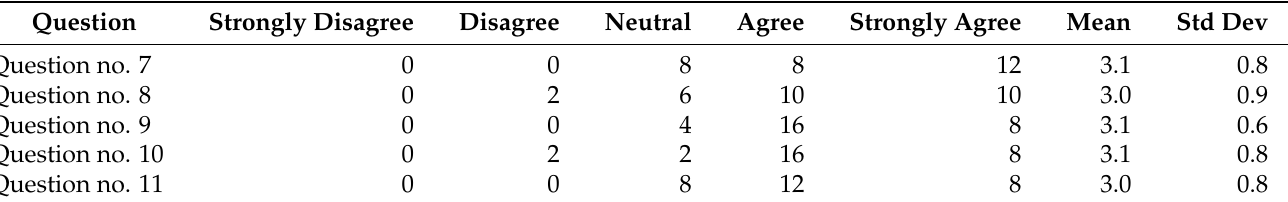
Table 12. Student questionnaire responses with mean and standard